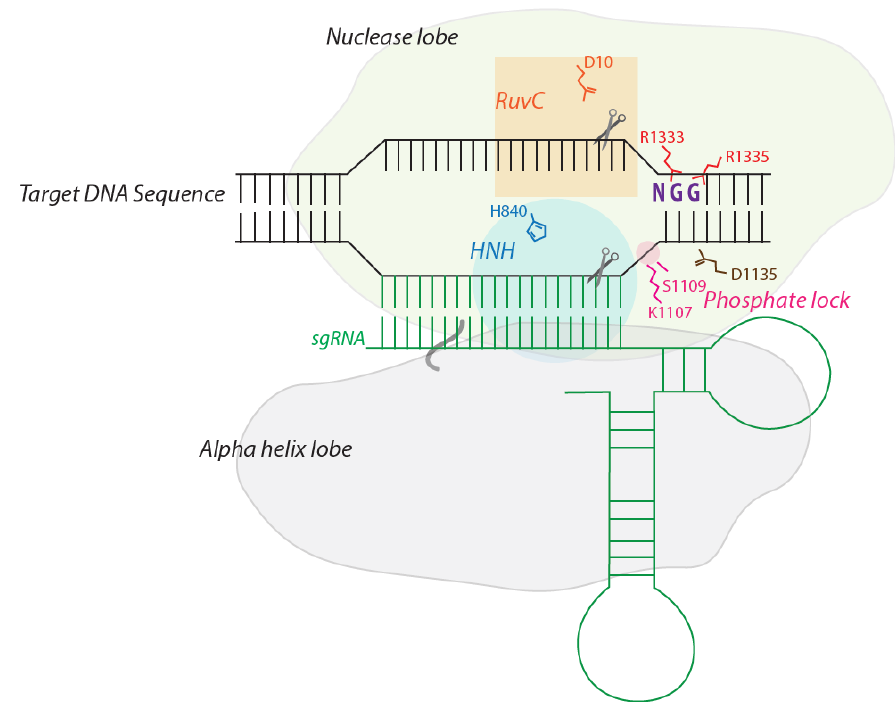
Figure 1. Streptococcus pyogenes (Sp) Cas9 recognition of target DNA. Sp Cas9 consists of two lobes, one containing the HNH and RuvC nuclease domains, and an α helix lobe. Arginine residues (R1333 and R1335) of Sp Cas9 recognize the dinucleotide guanine bases of the “NGG” protospacer adjacent motif (PAM). Then, serine (S1109) and lysine (K1107) form a phosphate lock by interacting with a phosphate residue adjacent to the PAM site, which triggers the melting of the double stranded DNA so that sgRNA (green) can form Watson–Crick pairing with a complementary DNA strand. D10 and H840 are the main catalytic residues in the HNH and RuvC nuclease domains, respectively. Aspartic acid at 1135 (D1135) interacts with the third PAM guanine residue through a water molecule, and a modification of the residue to glutamic acid (D1135E) has been shown to improve the recognition of PAM sequence and target